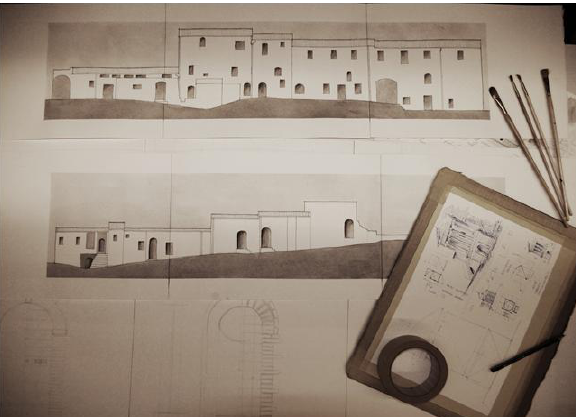
Figure 5. Risultati del rilievo diretto durante la Summer School